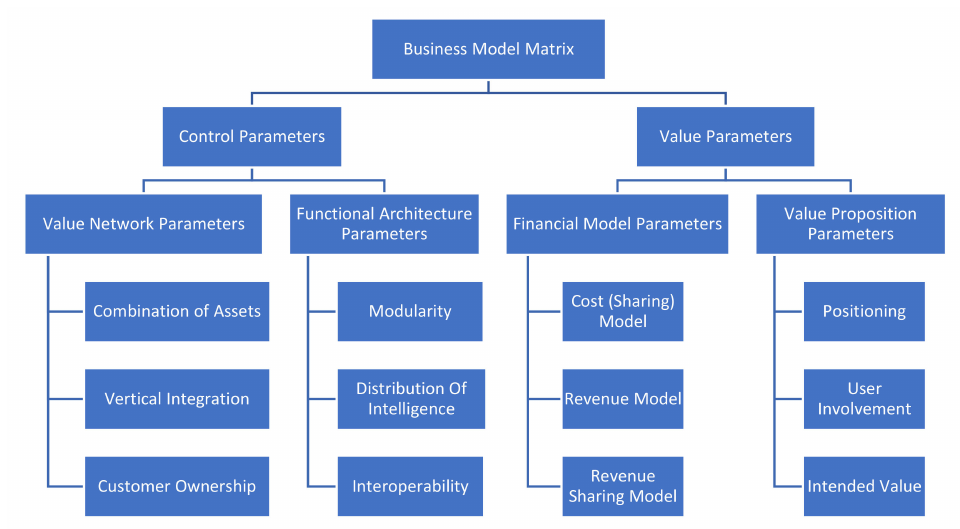
Figure 2. Business model matrix framework. Reproduced from [51], iMinds-SMIT, VUB: